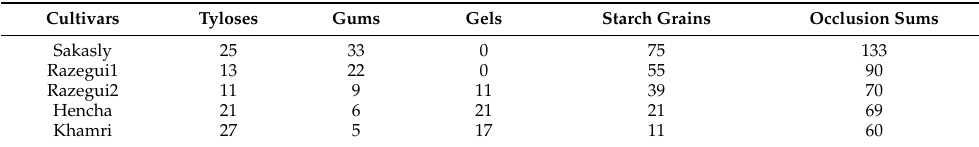
Table 1. Sum and type of occlusions recorded in xylem vessels among stem cross sections of local grapevine